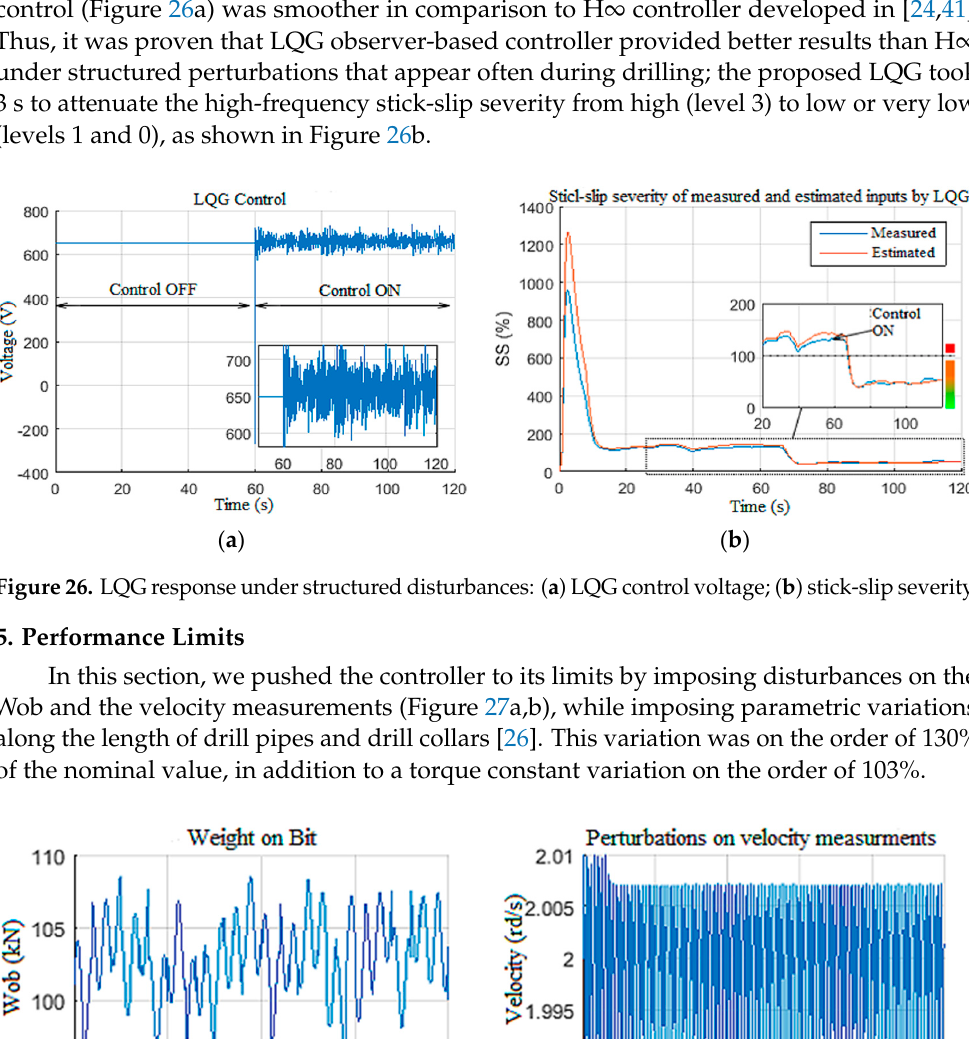
Figure 25. Comparison between LQG and H ∞ responses: ( a ) reference tracking with LQG; ( b ) refer-